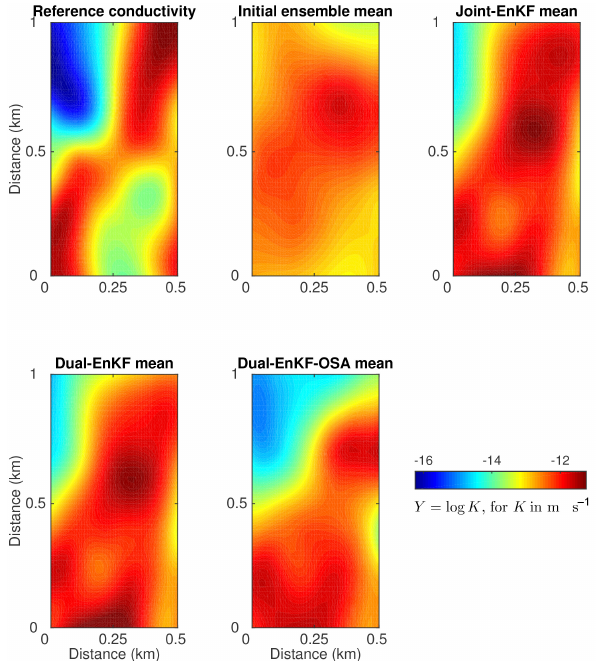
Figure 8. Spatial maps of the reference, initial and recovered en- semble means of hydraulic conductivity using the joint EnKF, dual EnKF, and dual EnKF OSA schemes. Results are shown for a sce- nario in which assimilation of hydraulic head data is obtained from nine wells every 5 days. This experiment uses 100 ensemble mem- bers and 0.10m as the measurement error standard deviation.